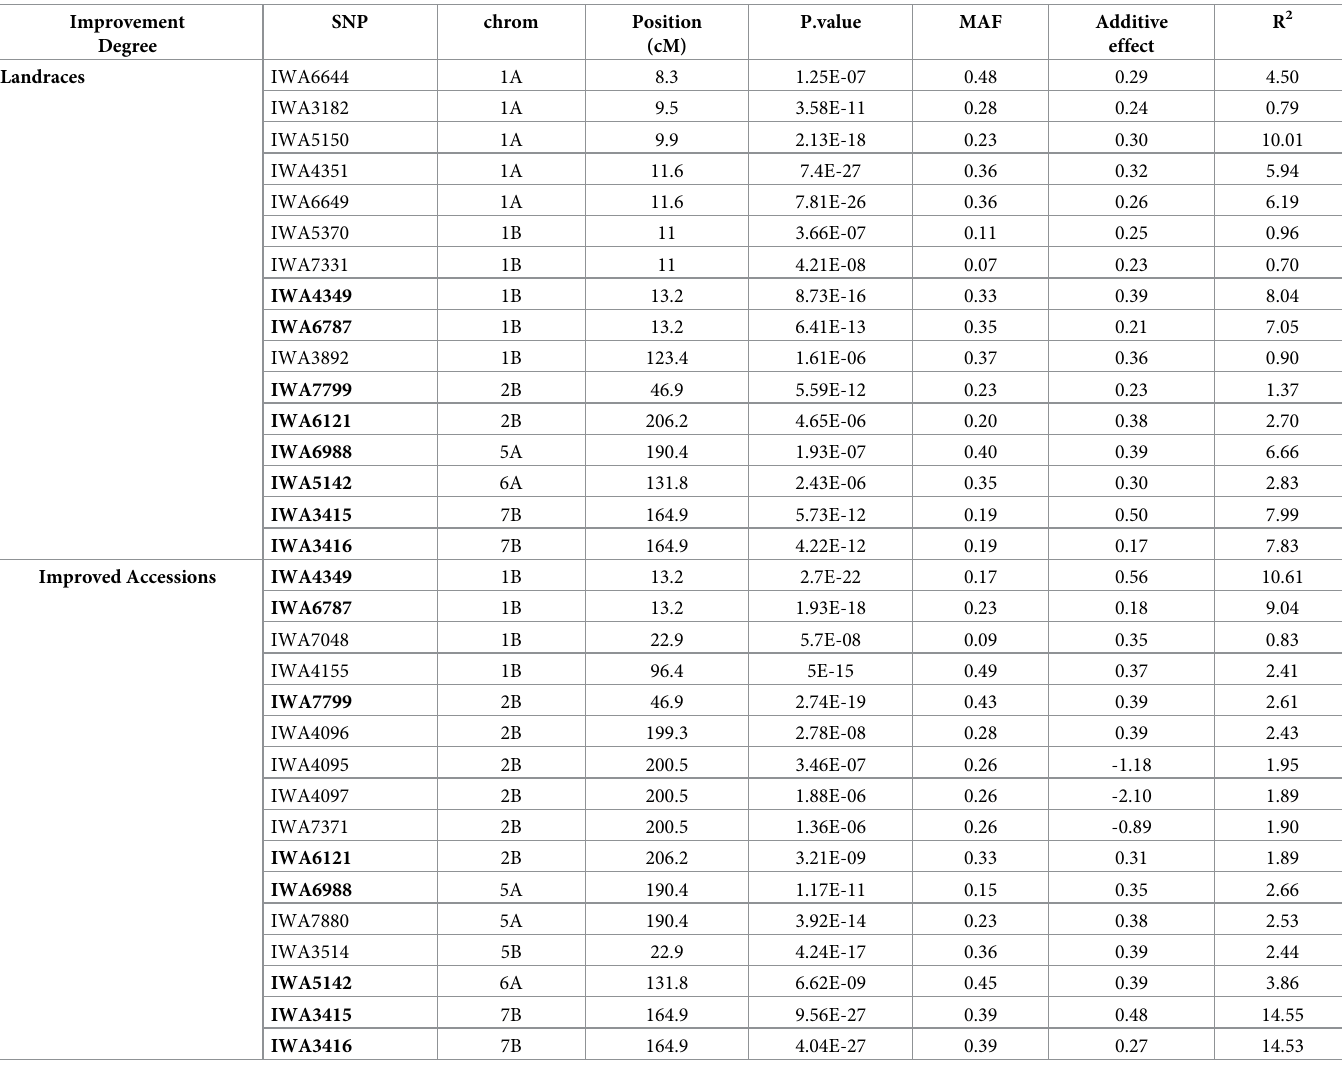
Table 1. Significant markers associated with stripe rust resistance in the landraces and improved accessions. Improvement Degree